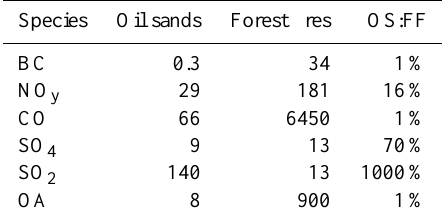
Table 4. Emissions from the oil sands in comparison to estimated forest fire production. BC, NO y , and CO are directly from Amiro et al. (2009), while the others use ratios to CO during fire plume penetrations in ARCTAS (as identified by acetonitrile > 0.5ppbv). Units are Ggyr − 1 . The SO 4 numbers are a bit misleading, as some of the SO 2 will react to create more sulfate.